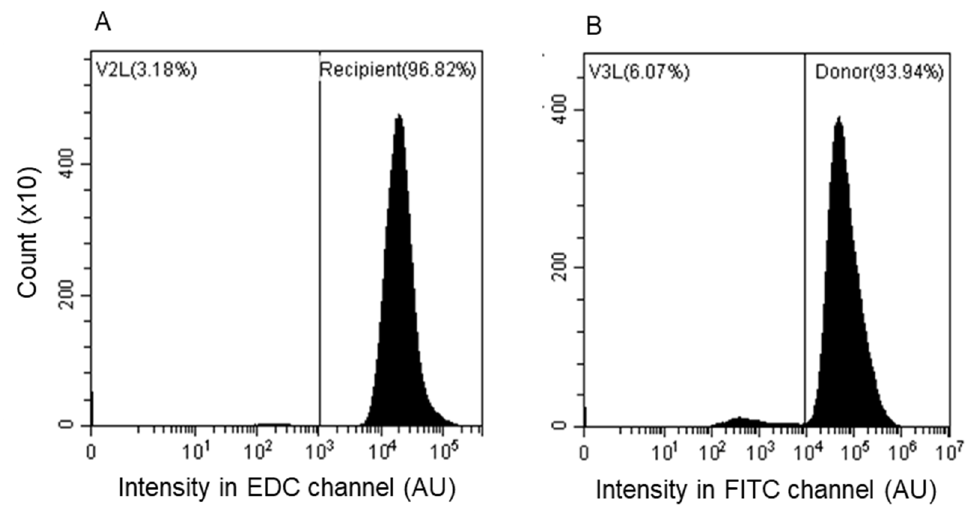
Figure A1. Determination of gate hierarchy. The negative populations V2L ( A ) and V3L ( B ) are defined as noise. The experiments were repeated three times with similar results and one set of representative plots is shown.